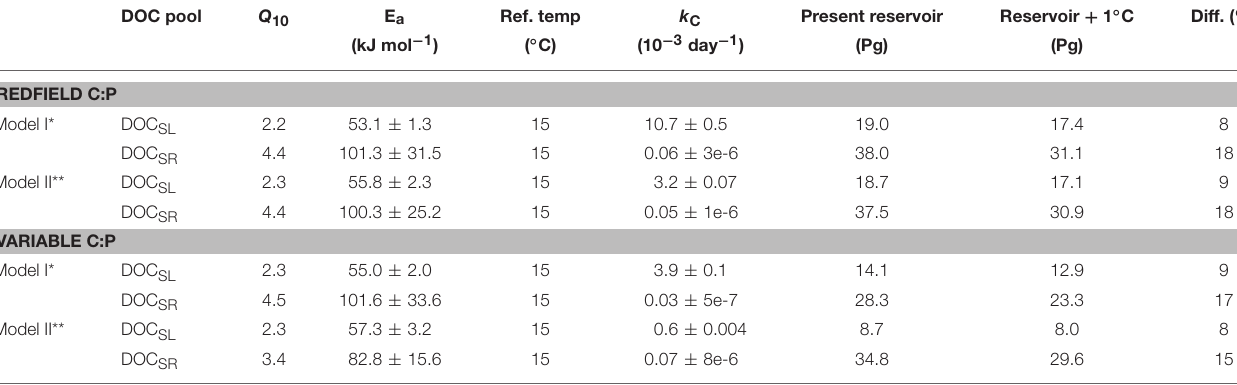
TABLE 2 | Model-obtained values for the temperature sensitivity of DOC